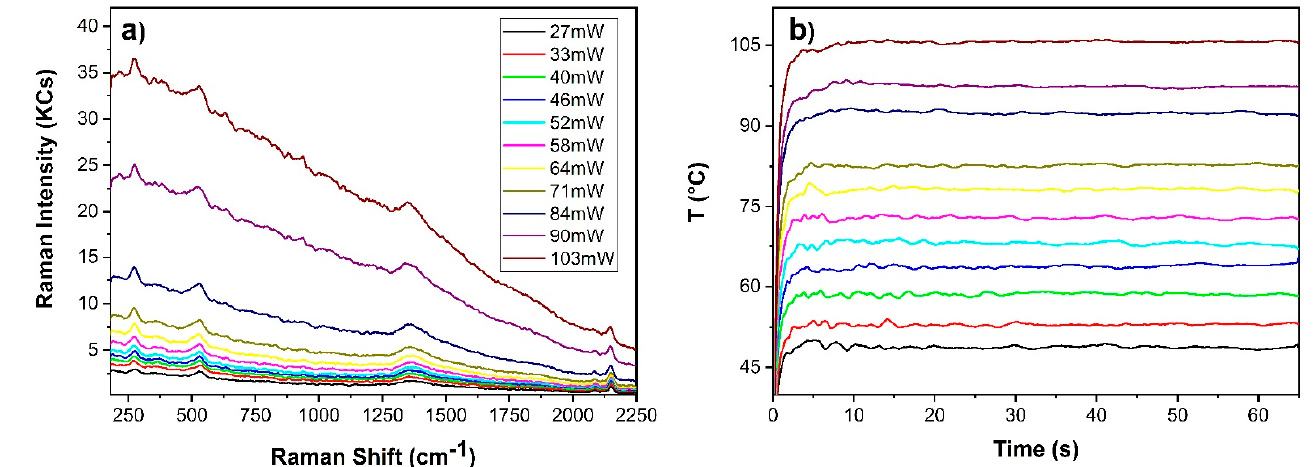
Figure 7. Prussian blue in linseed oil paint film: ( a ) smoothed Raman spectra collected with a single scan and integration time of 65 s; ( b ) associated temperature profiles. The emissivity value measured in situ was 0.97.